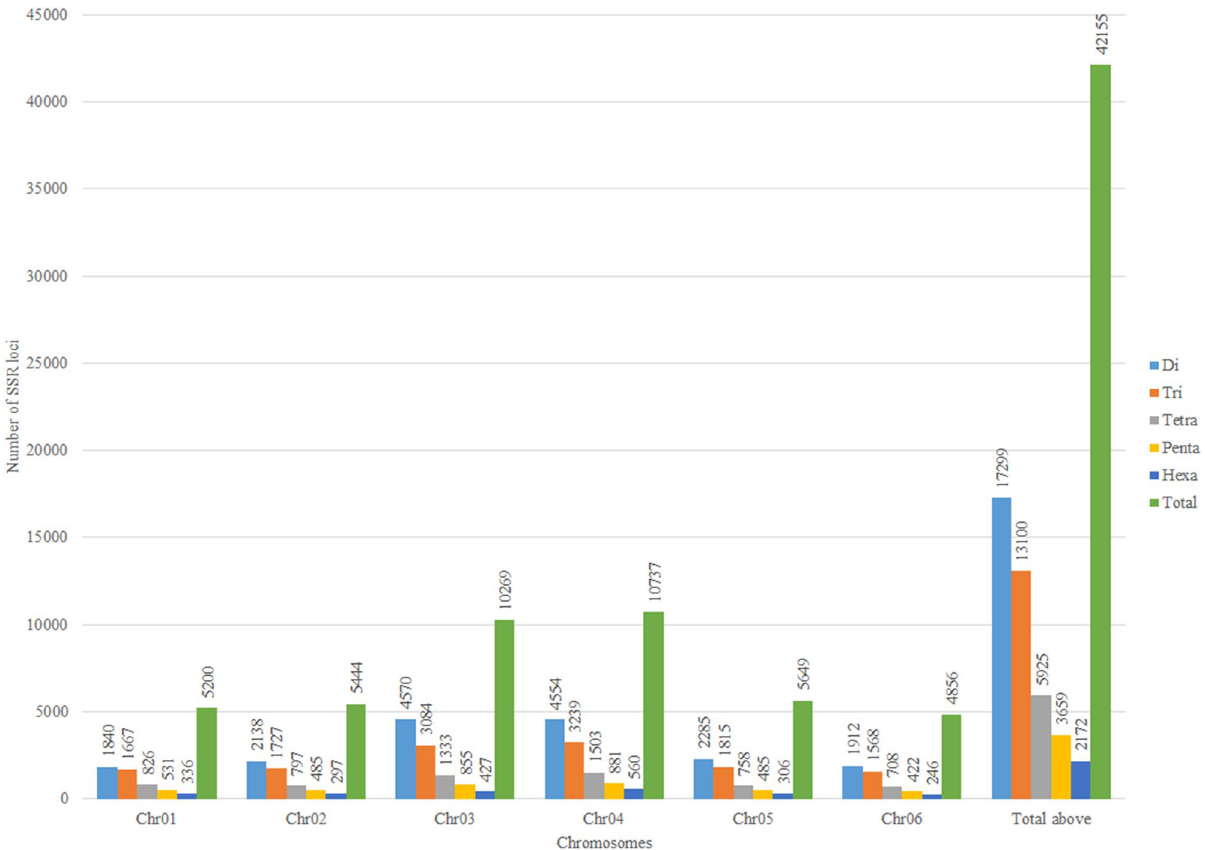
Figure 2. Chromosome-wise distribution of di, tri, tetra, penta, and hexanucleotides repeat SSR loci in the spinach average of 0.40 per locus. The polymorphic information content (PIC) of SSR markers ranged from 0.09 to 0.35 and averaged 0.25 (Table 3). Phylogenetic and population structure analysis. The STRU CTU RE software v.2.3.4 41 was used to infer the population structure of the 48 spinach accessions for K = 1–10. The Structure Harvester program was used to determine the most likely number of subpopulations that generated the highest delta K value for K = 3 and the second highest was for K = 4 (Supplementary Fig. S1), suggesting the spinach accessions used in this study underlies genetic differentiation of three main populations. We considered reporting the three population groups to assign the spinach accessions genotyped with the SSR markers in this study. A membership probability cutoff (Q value) of 0.50 was used to divide the spinach panel into three (Q1, Q2, and Q3) main populations, while the remaining accessions showing membership proportions Q < 0.5 were grouped as an admixed group (Qm). The classification of spinach accessions into the population groups are provided in Supplementary Table S1. A red, green, and blue color were labeled for the three subpopulations membership proportion Q1, Q2, and Q3 in the STRU CTU RE-plot (Fig. 5). The Q1 group comprised 17 accessions (35.4%), mostly the commercial spinach cultivars and landraces from Europe and the USA. Fifteen accessions (31.3%) were clustered in the Q2 group that comprised S. oleracea accessions from Central and Western Asia (Iran, Iraq, Turkey, and Syria). Accessions from China, Afghanistan, Pakistan, and Greece merge in the Q2 population, although these accessions also contain a significant ancestry proportion from the Q3 population. The Q3 group comprises 11 accessions (22.9%), includ- ing S. oleracea landraces from South and Eastern Asian countries (Nepal, South Korea, Hong Kong, Taiwan, and India). The S. turkestanica accessions from Turkmenistan and Uzbekistan and S. oleracea accession from the former Soviet Union also lie in the Q3 group along with the South and East Asian accessions. In addition, a few S. oleracea commercial cultivars (Meerkat, Lazio, and Pigeon) were also grouped in the Q3 population but shared 33–42% ancestry proportion to Q1 subpopulations. The remaining five accessions (10.4%) fell in the admixed Qm group. Of the admixed population, S. turkestanica accession from Germany and the S. oleracea accessions from Japan and Georgia fell in the admixed group but comprised more than 45% ancestry proportions to the Q3 subpopulation and were merged with the other Q3 accessions. On the other hand, the accessions from Ethiopia and Belgium showed a high ancestry proportion (48 and 44%) to the Q1 group. The genetic divergence among the accessions was further explored by performing PCA analysis in TASSEL 5.2.65 44 . The spinach accessions differentiated into three main clusters in the PCA plot (Fig. 6). Spinach acces- sions assignment in the PCA corresponded well to the STRU CTU RE assigned Q groups with some mismatches